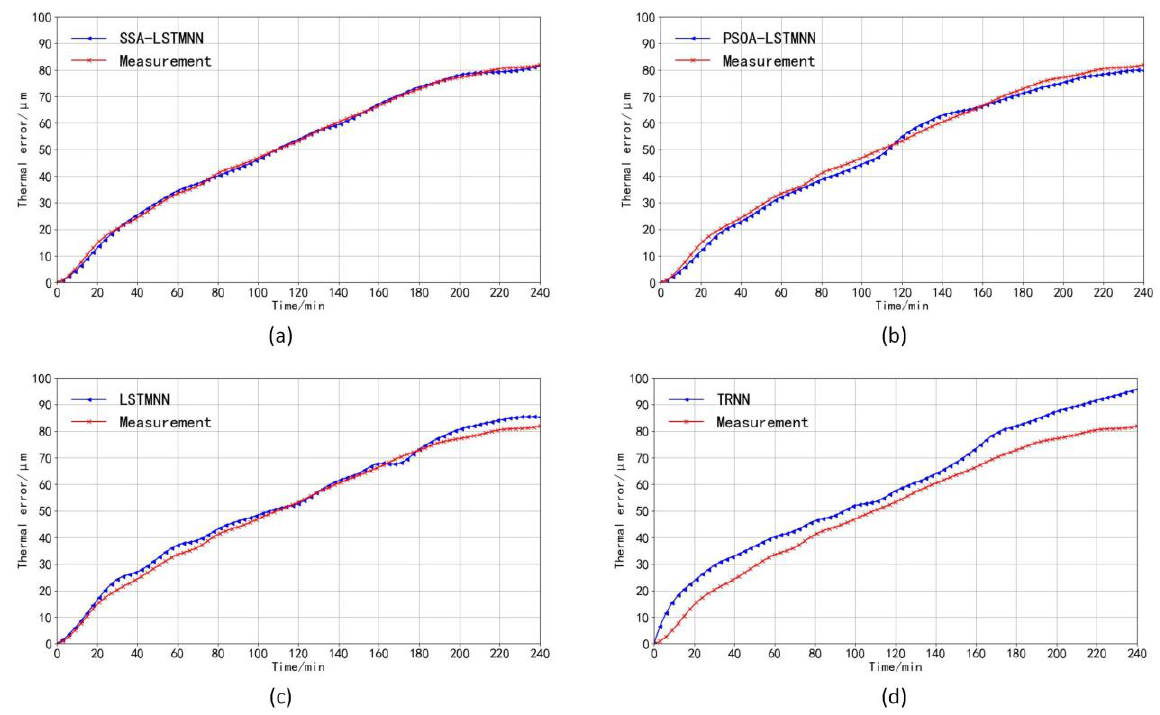
Figure 18. The prediction curve of each model at the speed of 5000 mm/min compared with the measured curve: ( a ) SSA-LSTMNN model, ( b ) PSOA-LSTMNN model, ( c ) LSTMNN model, and ( d ) TRNN model.